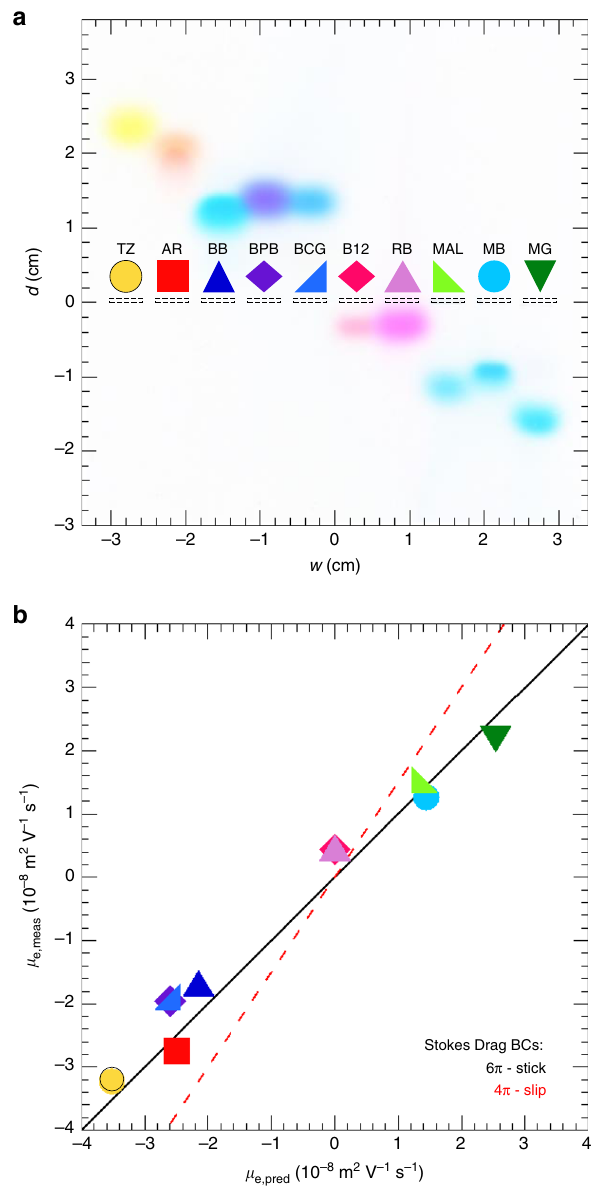
Fig. 3 Measured and predicted electrophoretic mobilities of organic dyes. Conditions: 3.0% (w/w) agarose gels; 5.0 mM SBB at pH 9.0; applied electric fi eld E = 3.1 V cm − 1 . a Image of bands of dye molecules after a propagation time t = 2,400 s from wells (dashed rectangles at d = 0). Propagation distance along the applied fi eld is d and the x -direction points downward; transverse distance is designated by w . Dyes are identi fi ed by abbreviations (see Fig. 2) and assigned symbols. b μ e,meas versus predicted μ e,pred using the Smoluchowski equation with stick boundary conditions for Stokes drag and effective hydrodynamic radii from molecular modeling (points). Black solid line: μ e,meas = μ e,pred (stick) has ideal slope = 1. Source data are provided as a Source Data fi ( − 2 e ) collides with MB( + e ), nearly all of the MB is consumed in a complexing reaction that generates a very long-lived stationary band, whereas a signi fi cant fraction of the more highly charged BB propagates through the collision without reacting (Fig. 4j – l).